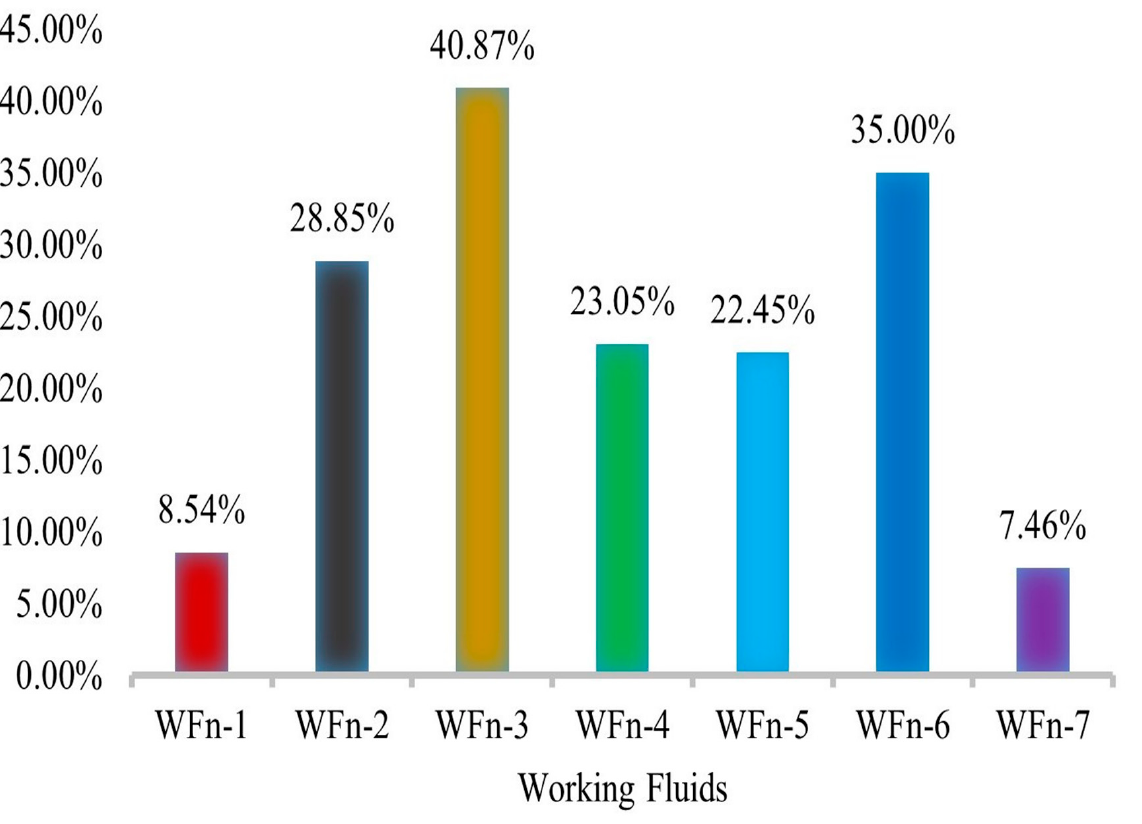
Figure 7. Demonstration on the obtained energy efficiency (%) using working fluid in multiple modes.